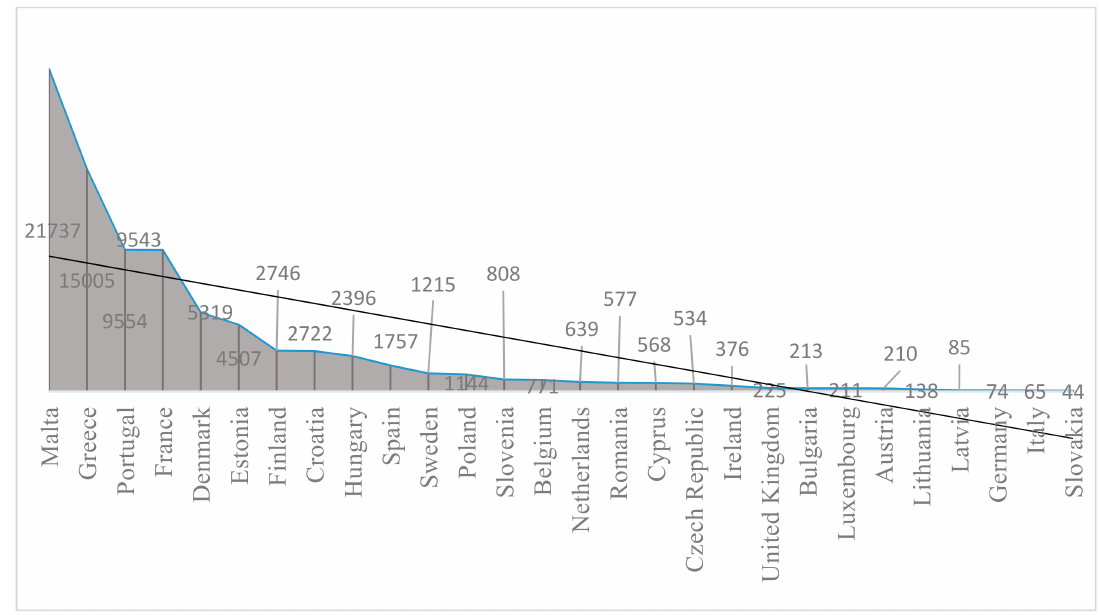
Figure 2. Total health expenditures on cancer: current prices for the 28 EU member states, 2014. High disparities in healthcare spending on cancer per inhabitant were observed across European states. The highest expenditure per capita is registered in Luxemburg (379 euro), while Denmark, Ireland, Italy, Finland, and the United Kingdom allocate less than half that amount. High values (above 200 euro) were also registered in Sweden, Austria, the Netherlands, Germany, Belgium, and France. The lowest values were registered in low-income countries like Bulgaria (29 euro) and Romania (27 euro) (Figure 3). After price differential adjustments, Central and Western Europeans registered healthcare expenditures of over 200 euro on cancer per inhabitant, while in Southern Europe (except Portugal and Croatia), per capita expenses were between 100 and 155 euro. Latvia (64 euro) and Romania (53 euro) registered the lowest